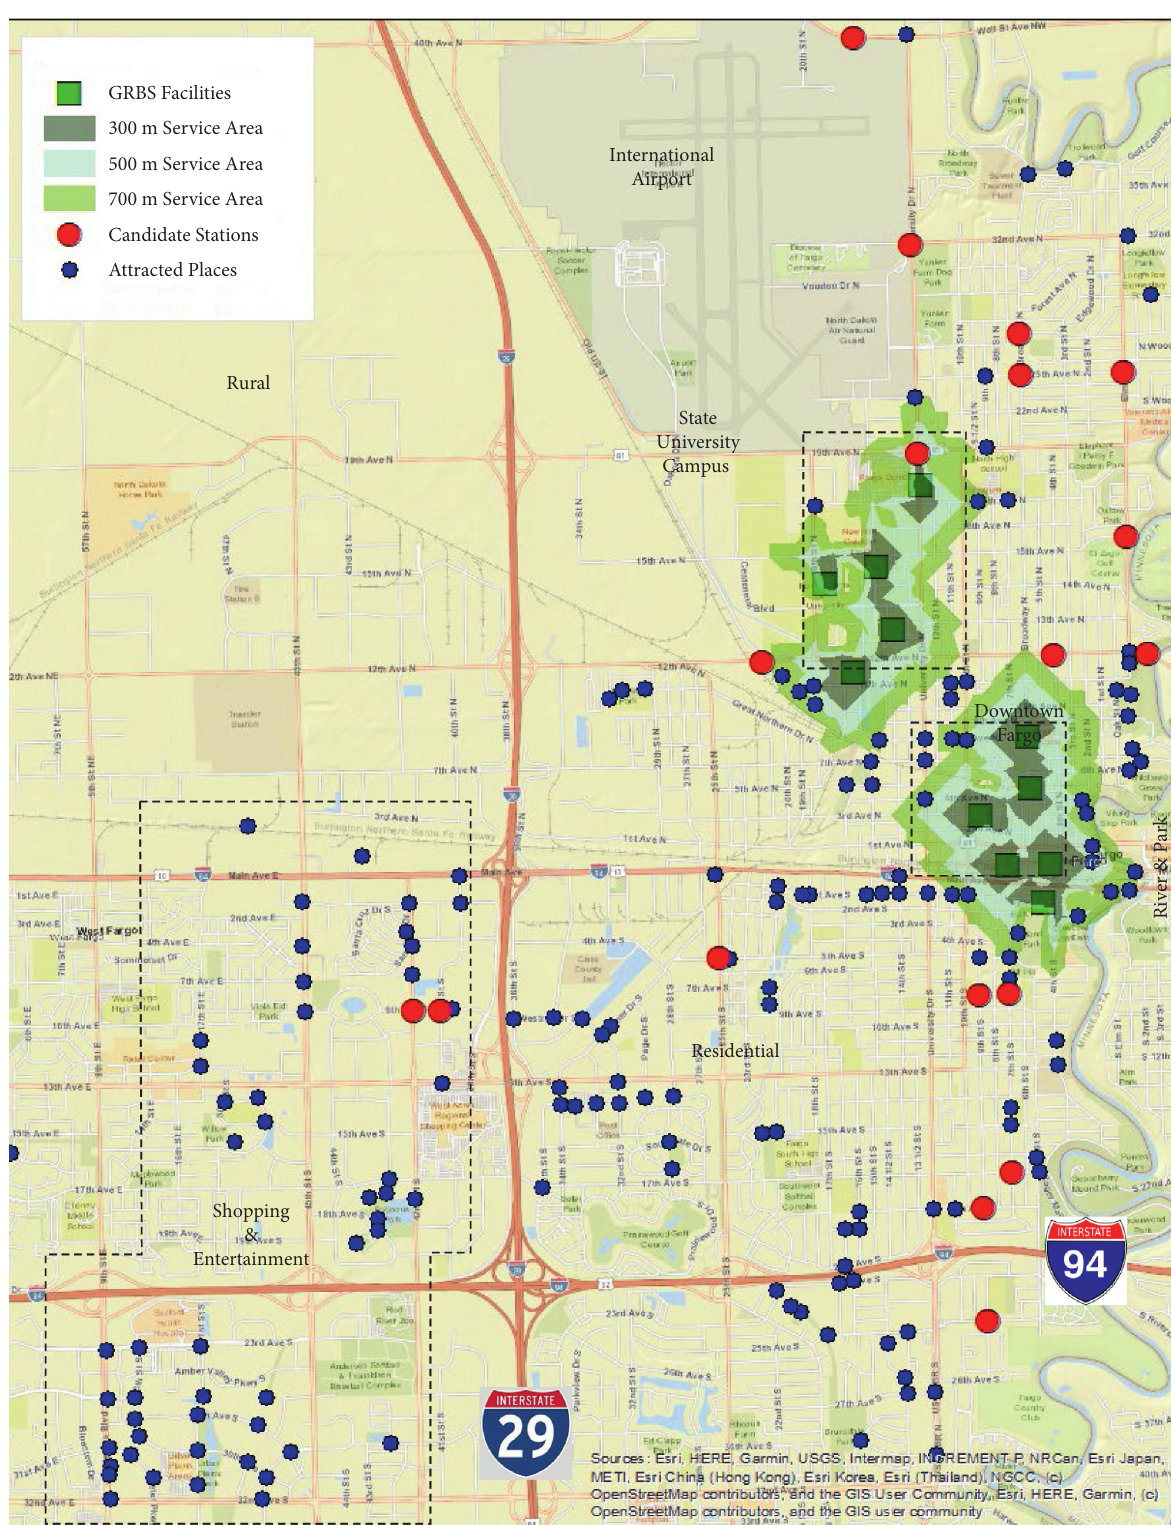
Figure 1: Service areas for the GRBS bike stations in Fargo, North